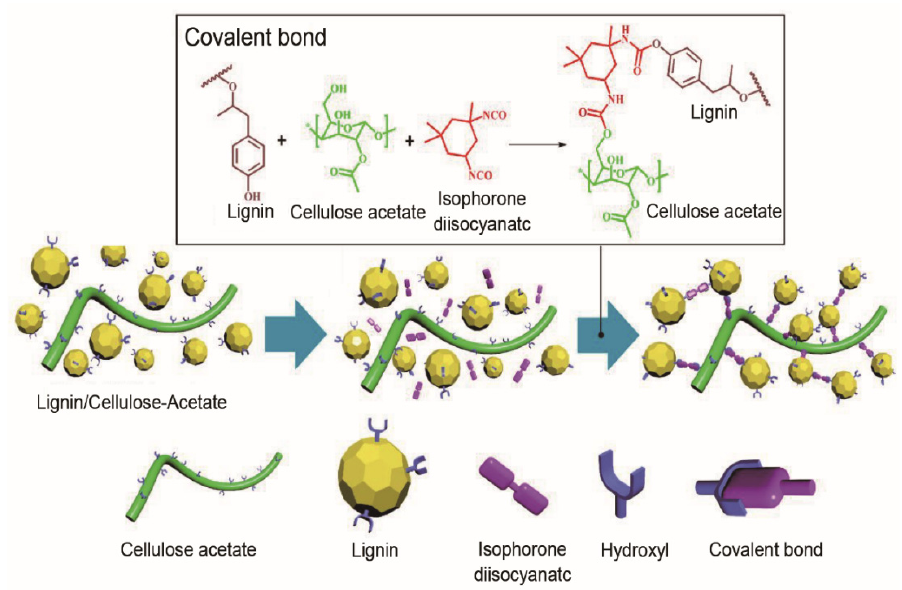
Figure 10. Preparation mechanism of modification reaction with lignin and cellulose acetate. Repro- duced with permission from ref. [151] Copyright 2019 American Chemical Society.